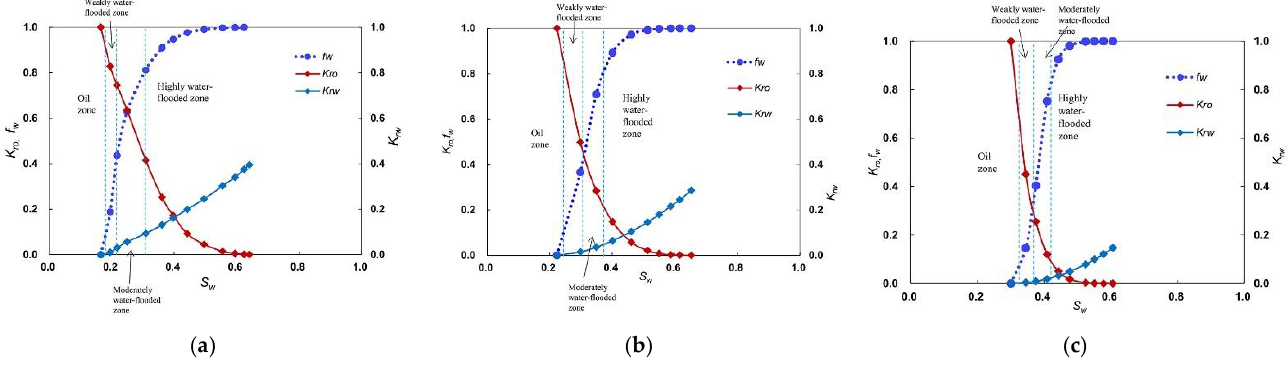
Figure 9. Oil – water relative permeability of classified reservoirs. ( a ) Class I reservoirs, ( b ) Class II reservoirs, and ( c ) Class III reservoirs.